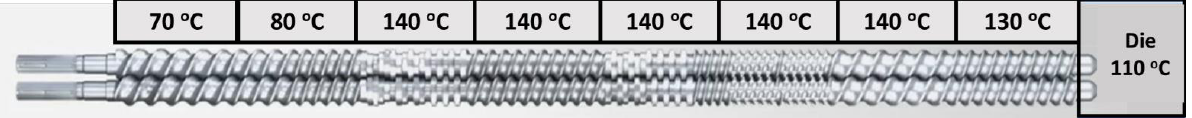
Figure 1. Screw design used for processing of filaments using a hot-melt extrusion